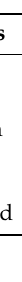
Table 2. Motor Rated